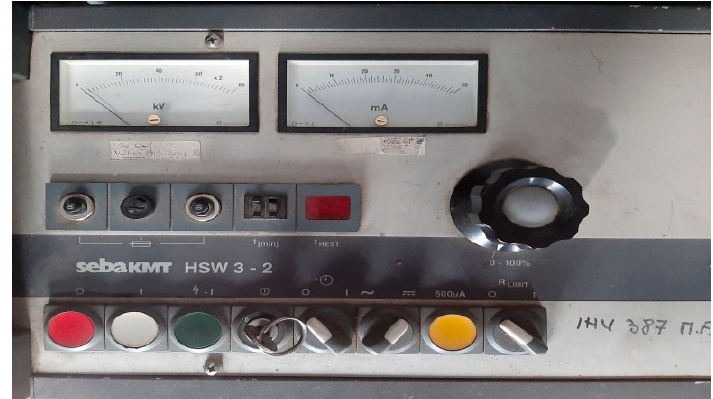
Figure 2. The interface of the command and measuring panel.